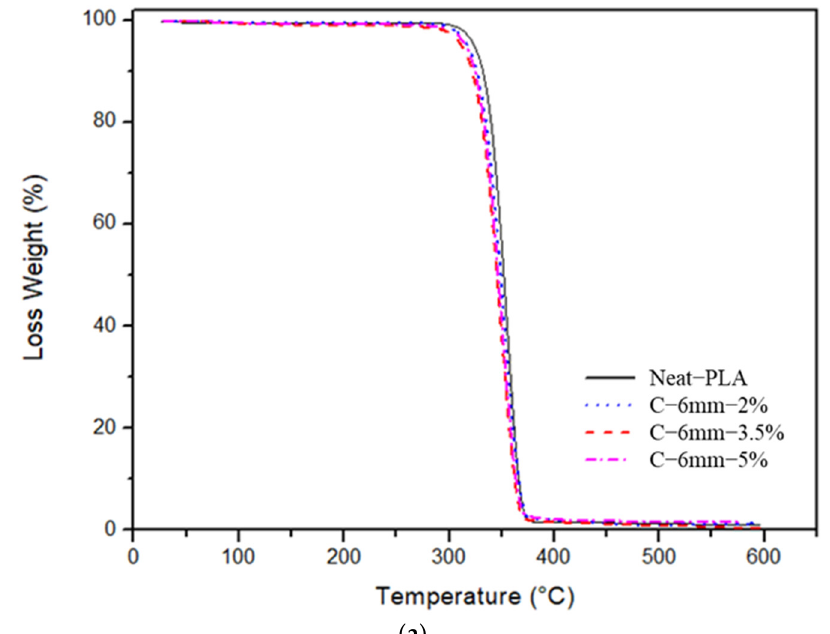
Figure 12. TGA analysis data: ( a ) TG curves; ( b ) DTG curves.